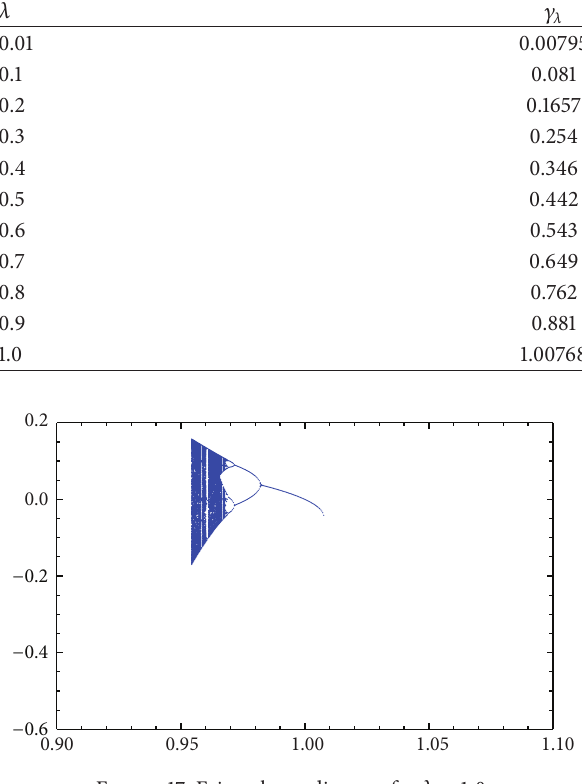
Figure 17: Feigembaun diagram for 𝜆 = 1.0 .